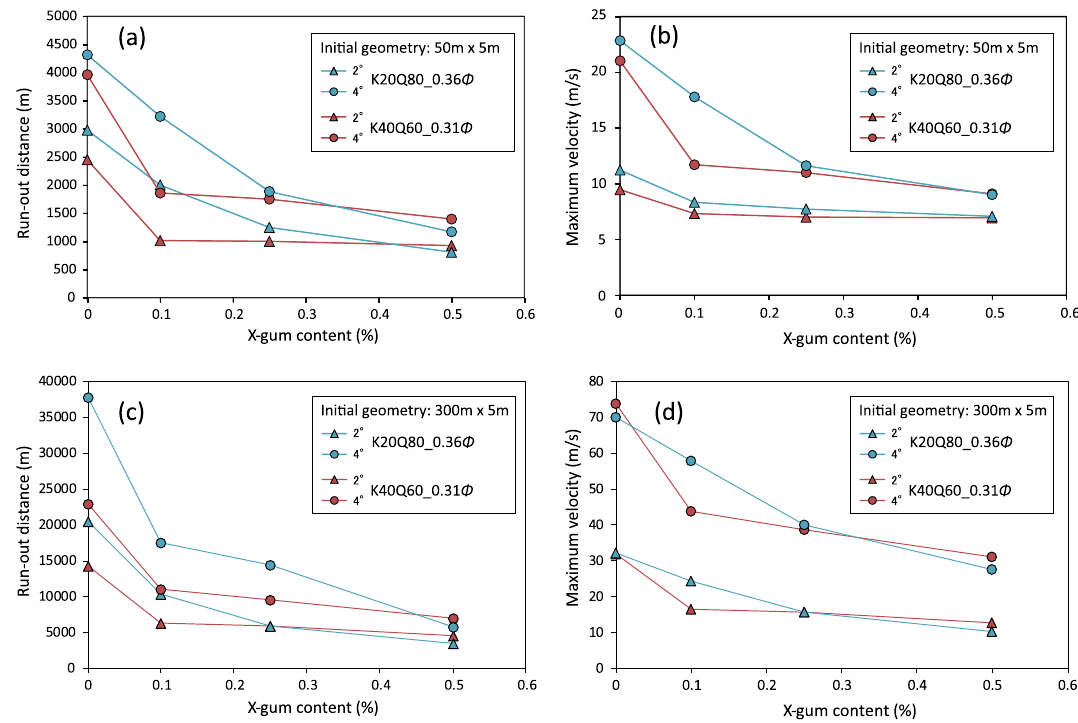
Figure 6. Run-out distances and maximum frontal velocities of two suspensions (K20Q80_0.36 Φ and K40Q60_0.31 Φ ) on 2° and 4° slopes calculated using the BING program as a function of xanthan gum content. Initial geometries of the deposits are 50 m length × 5 m height (with a parabolic shape) in ( a , b ), and 300 m length × 5 m height in ( c , d